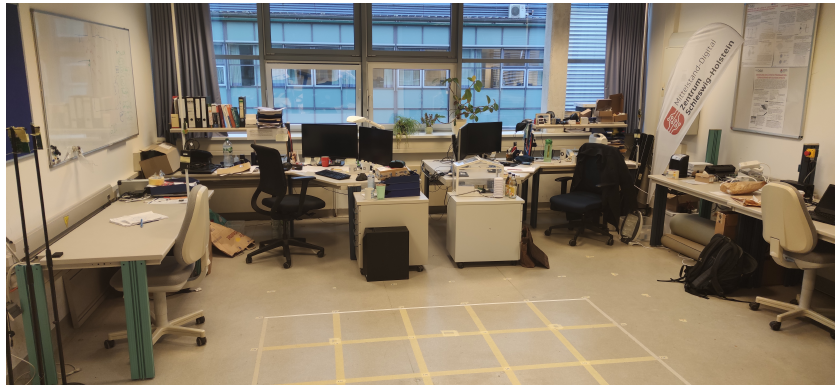
Figure 9. Photograph of the room.